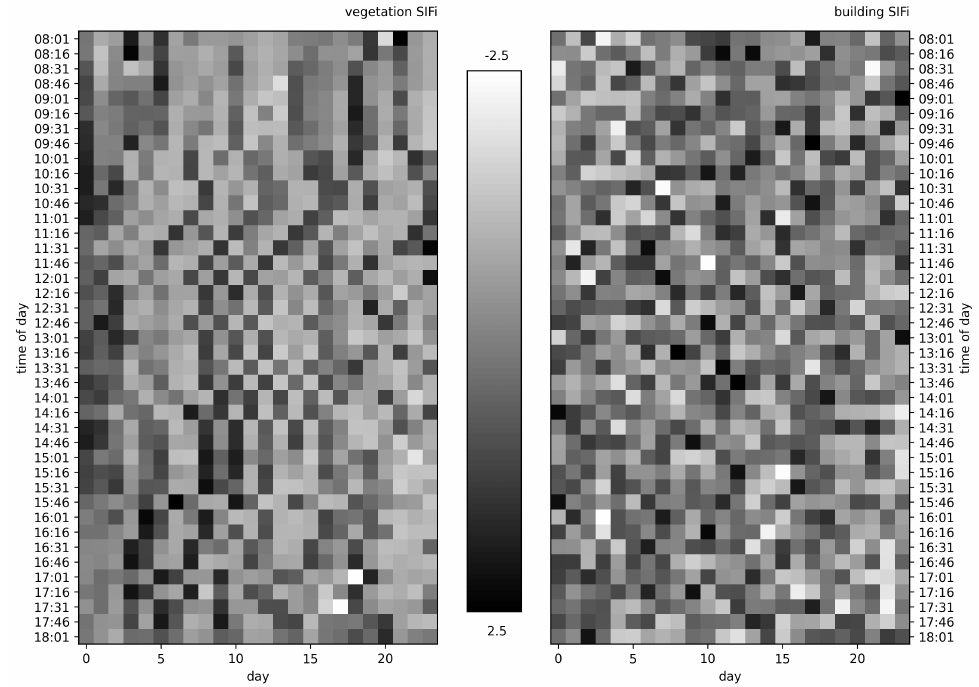
Figure 13. Solar-Induced Fluorescence indicator ( SIFi ) for vegetation ( left ) and buildings ( right ) standardized horizontally for each time-of-day series plotted for each day vertically. Each horizontal time-of-day series is independent of diurnal correlations between solar angles, temperature, ozone, and vegetation health indicators since each data point is captured daily at the same